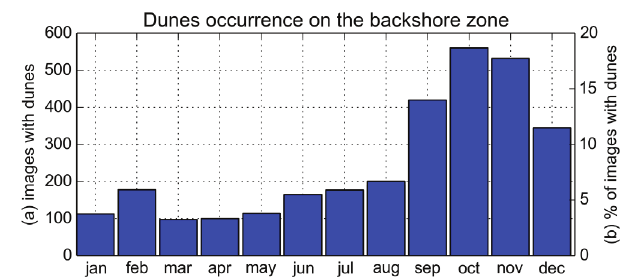
Figure 7 - Dunes occurrence per month at the backshore zone during the years of 2005, 2006 and 2007. The ( b ) axis show a Normalized data from axis ( a ), showing number of images with dunes during each month compared to the total number of images collected that month, as a